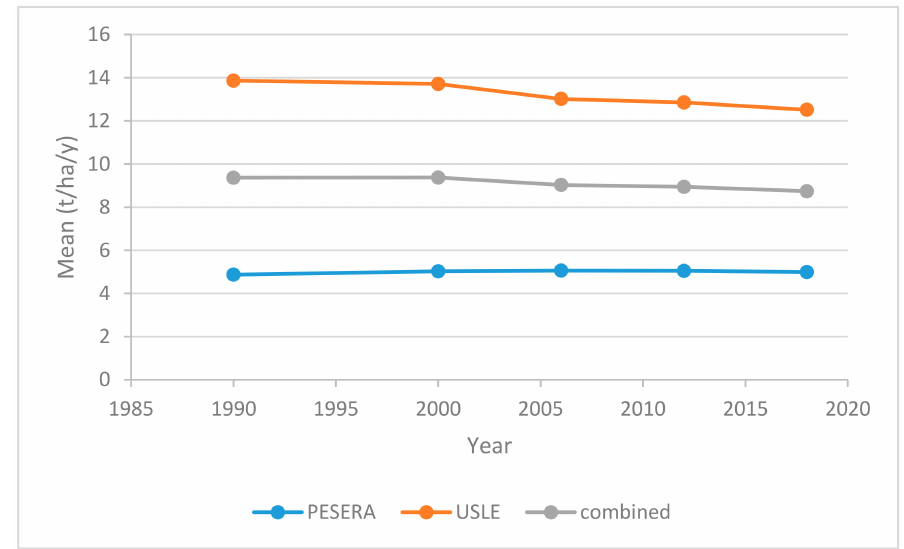
Figure 10. Changes in mean estimated soil loss over time, by using the PESERA and USLE models and their combination.